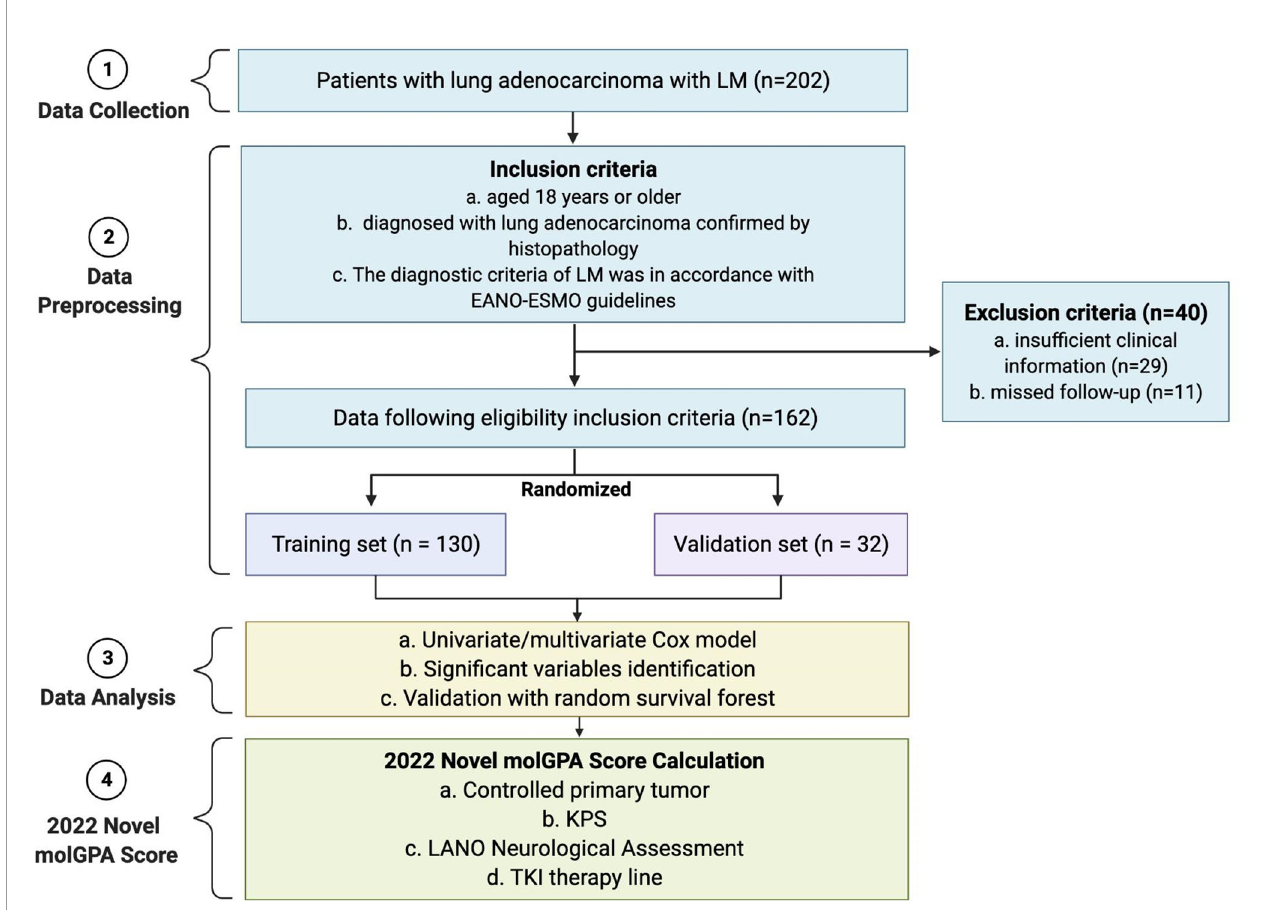
FIGURE 1 | Flow diagram of the enrollment of patients with lung adenocarcinoma with LM, and pipeline of data analysis to get the 2022 molGPA score. LM, leptomeningeal metastases; EANO-ESMO, European Association of Neuro-Oncology-European Society for Medical Oncology. KPS, Karnofsky performance status; LANO, Leptomeningeal Assessment in Neuro-Oncology; TKI, tyrosine kinase inhibitor; GPA, Graded Prognostic